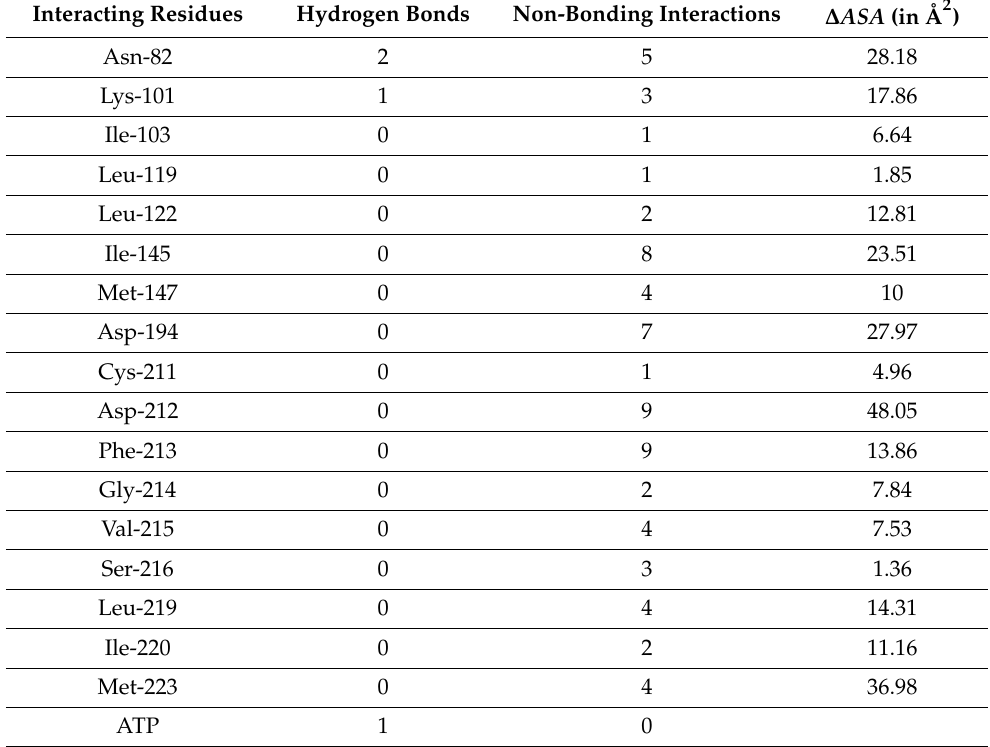
Table A5. The MEK2 residues interacting with selected flavonoid M2F5 are listed with the number of non-bonding interactions and ∆ ASA